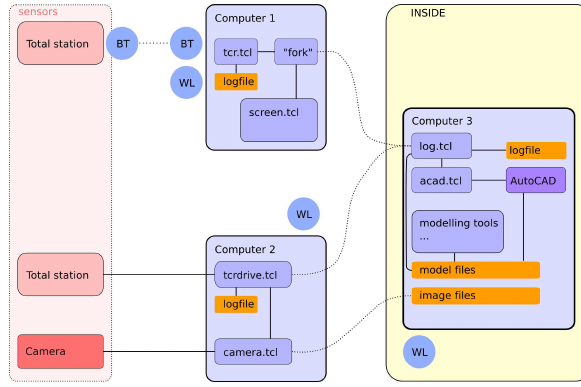
Figure 2: Example of setup: 3 computers, 2 total stations and 1 camera.